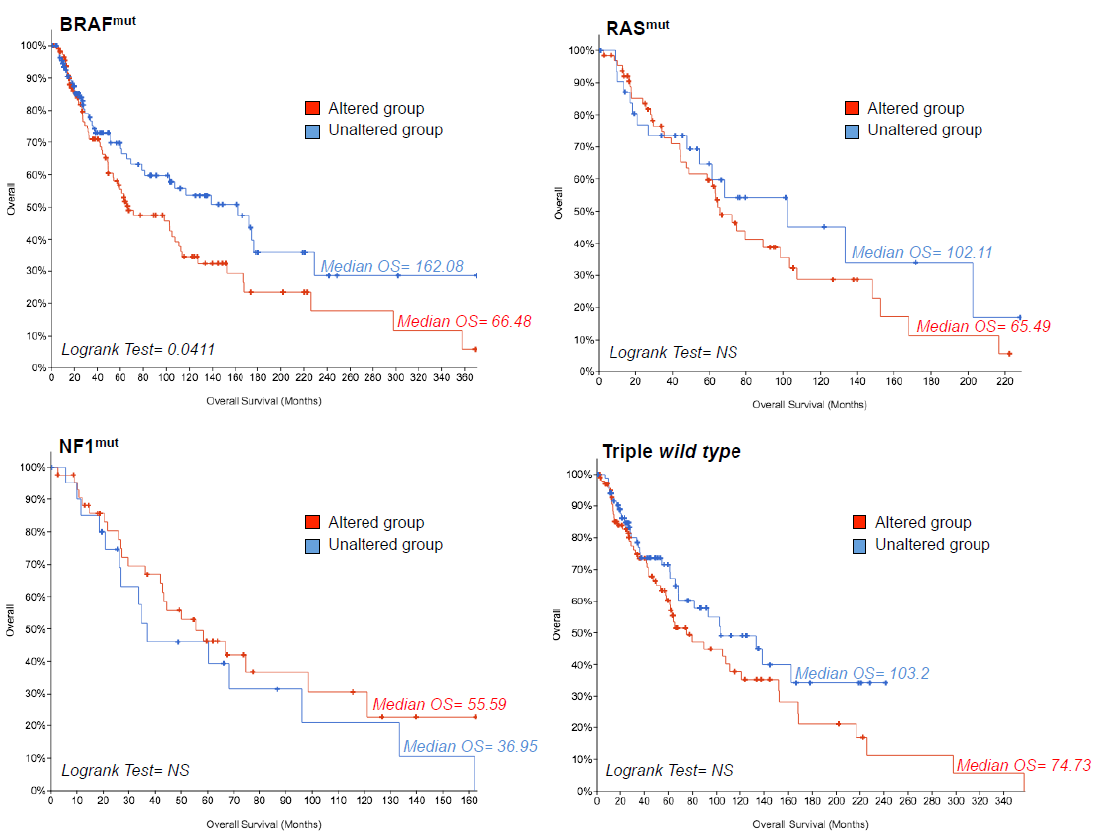
Figure 5. Kaplan–Meyer curves evaluating the prognostic value of “MSCsign” in the four mutational Figure 5 subtypes of skin cutaneous melanoma. Data plotted from https: // www.cbioportal.org /